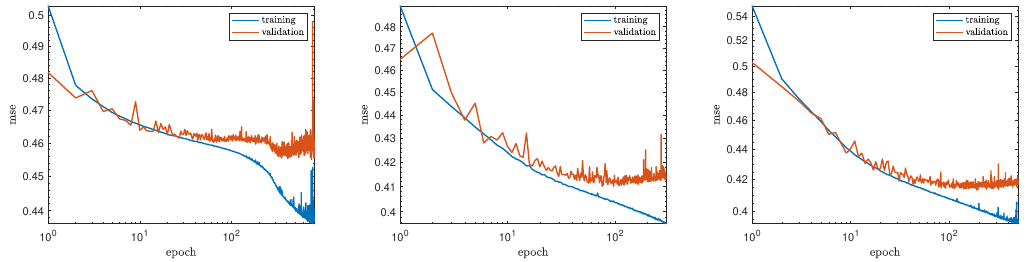
√ ˆ s . The left (middle) [right] panel